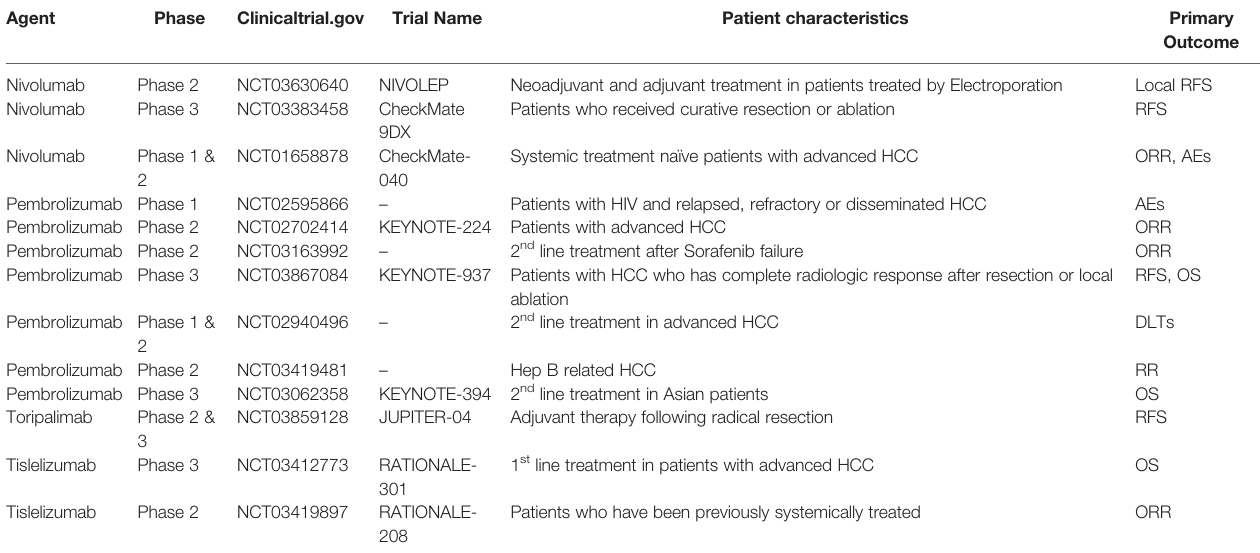
TABLE 1 | Ongoing clinical trials of monotherapy for immune checkpoint inhibitors in hepatocellular carcinoma (HCC).